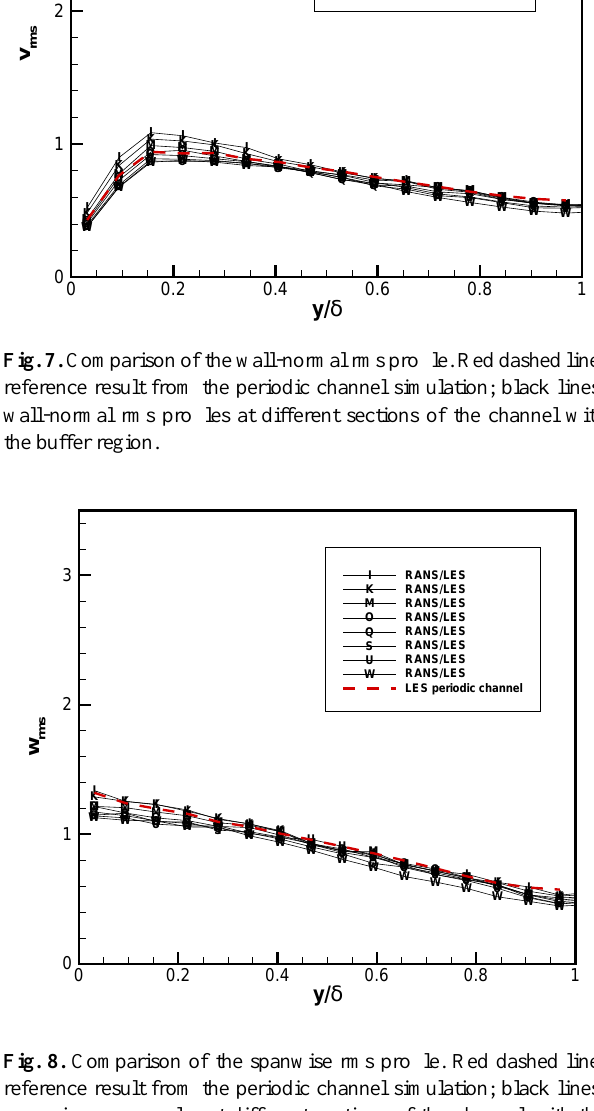
sections in which time averaged velocity profiles are mon-